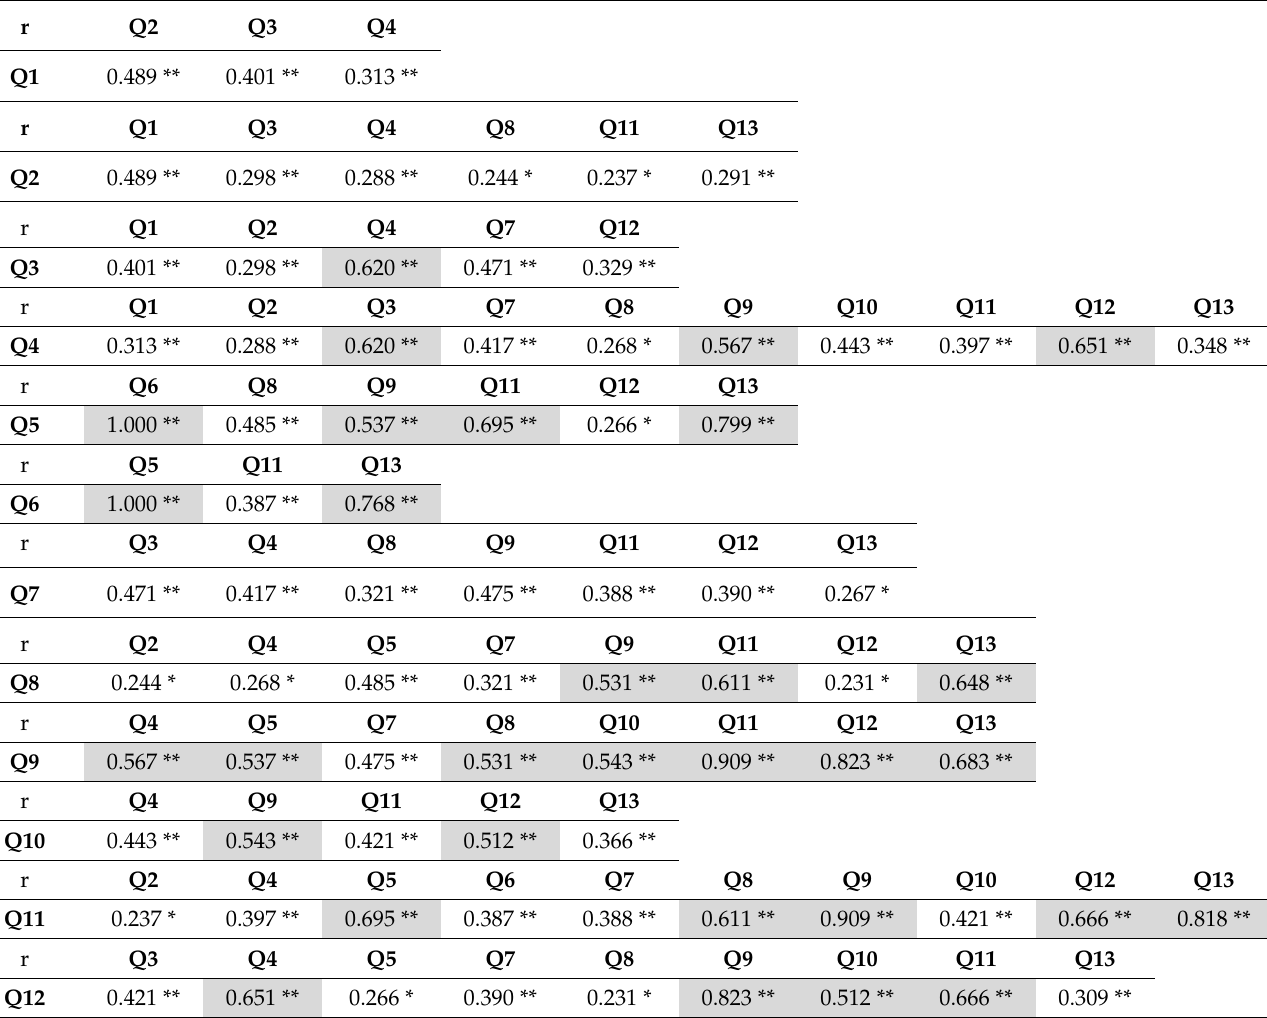
Table 6. Significant Pearson’s correlation results between each question from the